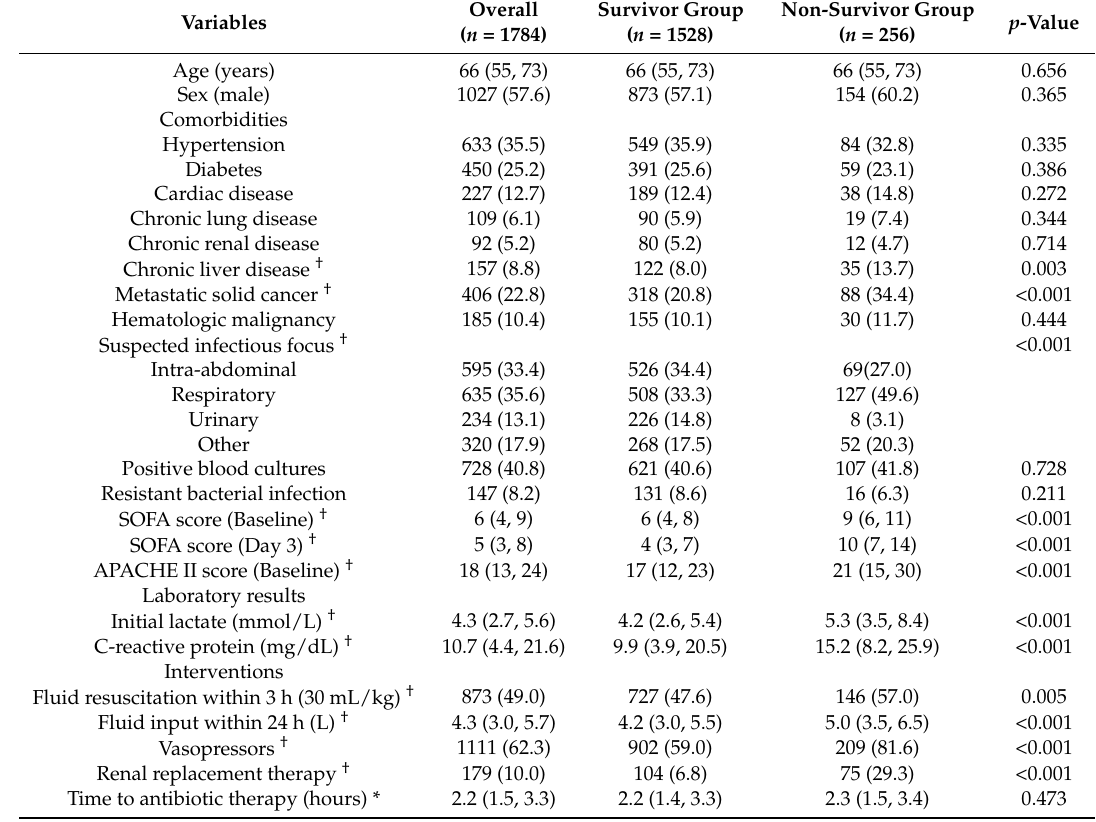
Table 1. Baseline